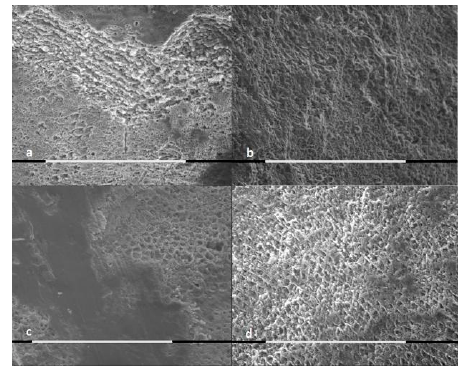
Figure 3. SEM pictures (800×, marker 100 μ m) of enamel exposed to lactic acid for 5 min: ( a ) enamel brushed with AZ ProExpert ® toothpaste; ( b ) untreated controls; ( c ) enamel treated with Colgate Total Original ® toothpaste; and ( d ) untreated controls. 4. Discussion Dental erosion has a multifactorial etiology: the main factors are a poor oral hygiene or an inadequate hygienic technique, a diet rich in carbohydrates or a frequent intake of soft drinks and some factors linked to systemic diseases. All these elements can expose the dental enamel to acid attacks [25–27] and increased dental permeability [28,29]. This study examined the citric acid, because of its presence in many drinks and wide use in food; the lactic acid, because of its involvement in the carious pathogenesis process; and the hydrochloric acid, because it is the most important component of gastric juices and it could be present in the oral cavity in conditions of vomiting or reflux [30–33]. Sodium fluoride-based toothpastes are the most widely used prevention tool for these acid exposure [17]. The present experimentation aimed to evaluate the effects of a single dose application of a new toothpaste with stannous fluoride on enamel exposed to acid solutions, in comparison with a sodium fluoride based one. Sodium fluoride and stannous fluoride act in a different way: the former operates more effectively as a result of the acid attack; the latter has an optimal action if applied before the erosive challenge. This means that the sodium fluoride has an optimal action during the first erosive attacks, while the stannous fluoride is more effective following repeated acid attacks, and therefore it is more suitable to inhibit enamel erosion in patients exposed to multiple erosive attacks [18]. The stannous fluoride is reported to offer protection against acid attacks due to the deposition of a barrier containing tin fluorophosphate, and its effect is active also at a 2.2 pH [21].